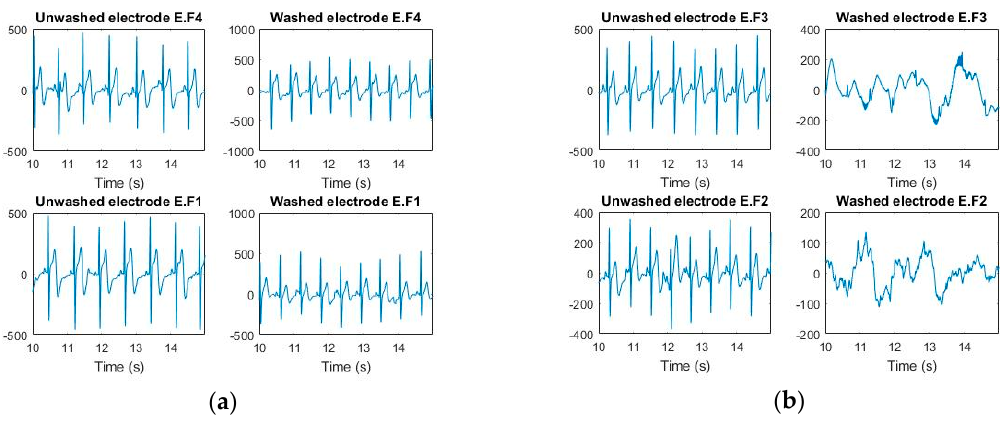
Figure 8. ECGs measured (express wash). ( a ) F1 and F4 ( b ) F2 and F3.